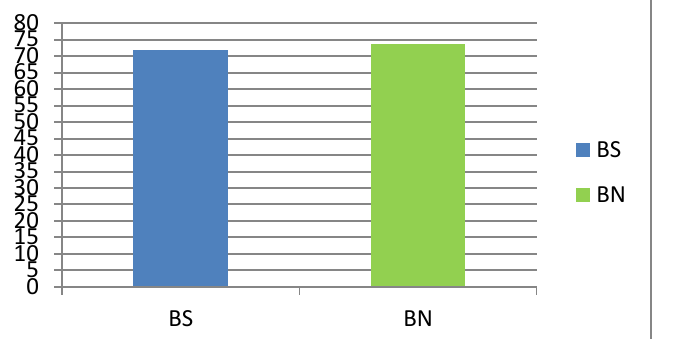
Figure (3) Bupivacaine with normal saline versus bupivacaine with nefopam in term of weight in kilogram, there is no significant statistical difference (p=0.234).